Question: What does this figure show? Answer in one sentence.
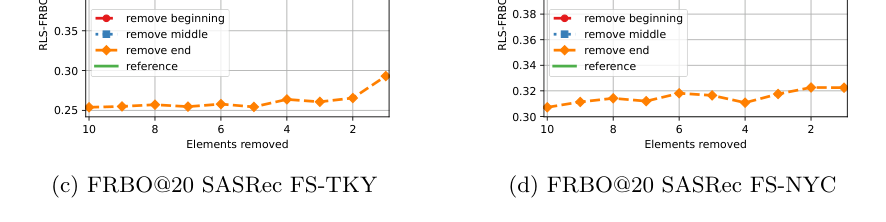
Answer: Plots of NDCG and FRBO for SASRec on FS-TKY and FS-NYC datasets. The baseline is shown as a horizontal solid line, while dashed lines show the met- rics as the number of items removed changes for the three scenarios considered.